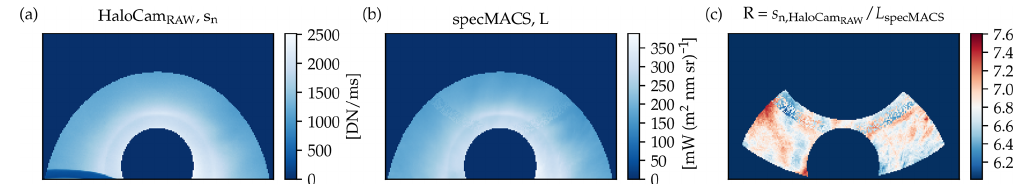
Figure 9. (a) HaloCam RAW normalized and flat-field-corrected signal s n (DNms − 1 ) for the R channel (10:29:20UTC) and (b) specMACS radiance L weighted with the HaloCam RAW spectral response of the R channel showing the upper part of the 22 ◦ halo on 22 September 2015 (10:28:17–10:30:27UTC). (c) The radiometric response was calculated by dividing s n , HaloCam the same angular grid. The image region was chosen to avoid the specMACS scan above the sun, which might be stray light contaminated, and the lower part of the HaloCam RAW image, which happened to be obstructed by a cable in this instance.